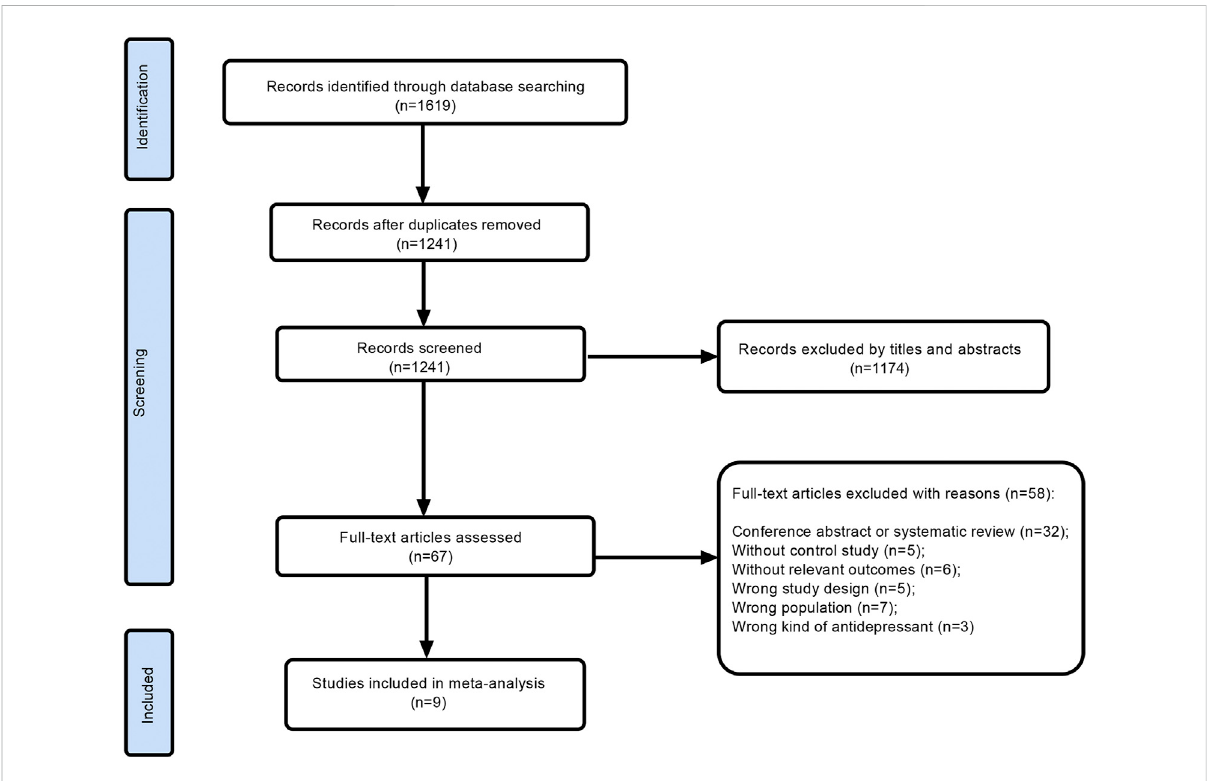
FIGURE 1 Flow diagram of assessment of